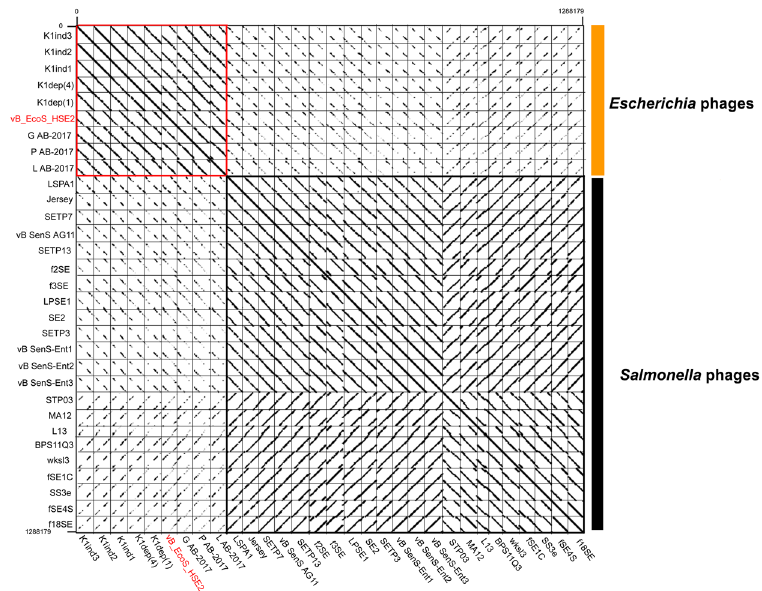
Figure 5. Comparative genomic analysis of phages that were similar with phage vB_EcoS_HSE2. The phages with genome similarity higher than 20% were collected from GenBank and used for dot plot analysis. The dot plot analysis was performed by using Gepard.